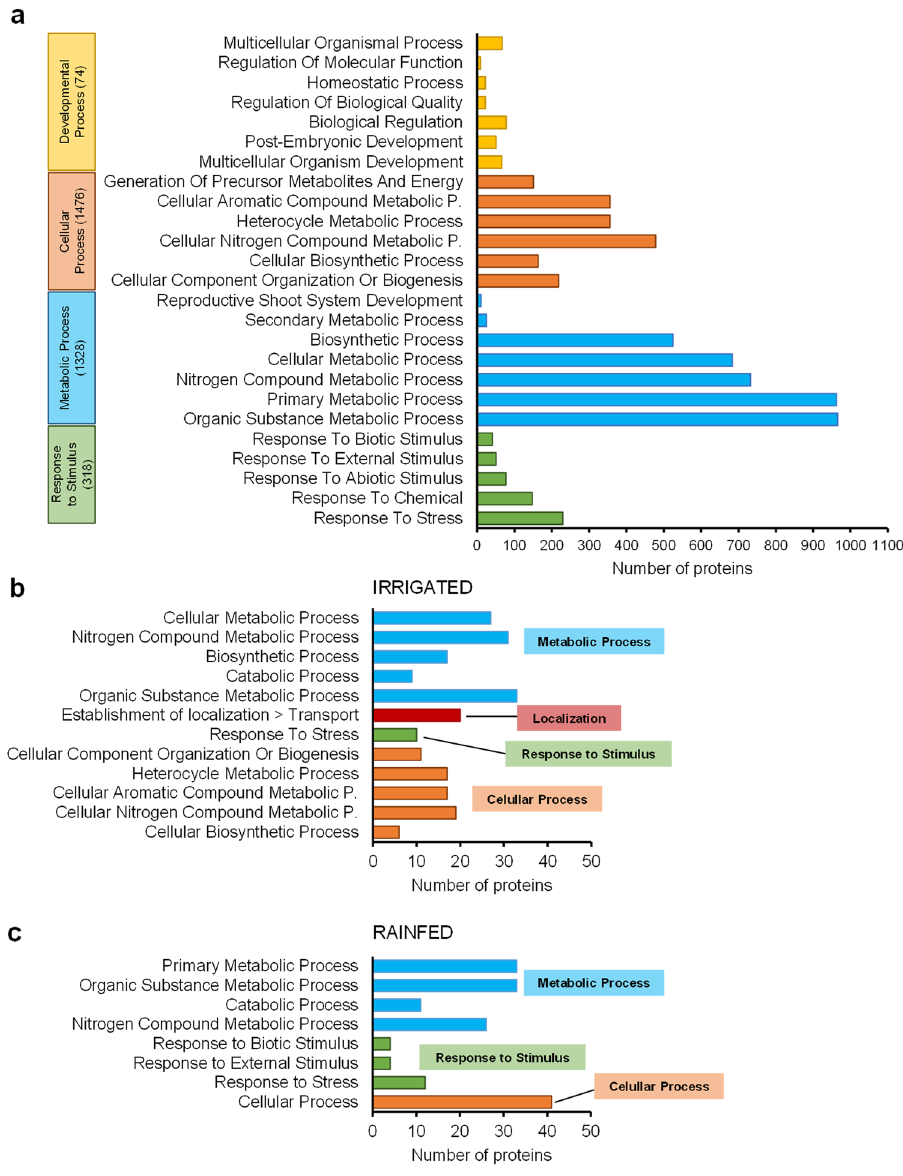
Figure 2. Seed proteins harvested from irrigated and rainfed conditions classified by gene ontology (GO) terms related to Biological Process (BP). ( a ) From the total of 2388 proteins quantified which were found in both conditions, 1960 were associated to BP-GO terms. In the graphs, the widest GO terms related to BP identified for these 1960 proteins were represented. ( b ) From the 103 proteins quantified exclusively under irrigated conditions, 81 were associated with BP-GO terms. ( c ) From the 86 proteins quantified exclusively under rainfed conditions, 81 were associated with BP-GO